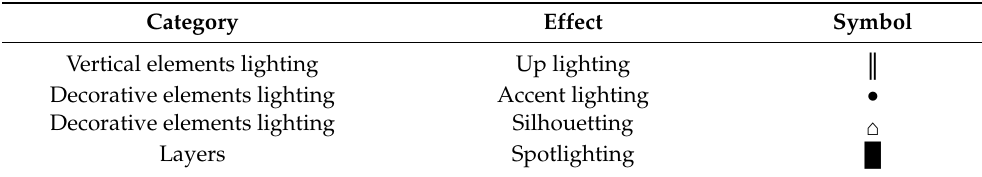
Table 1. This is a tentative list of symbolizing lighting techniques, created by the authors, based on previous works [64].